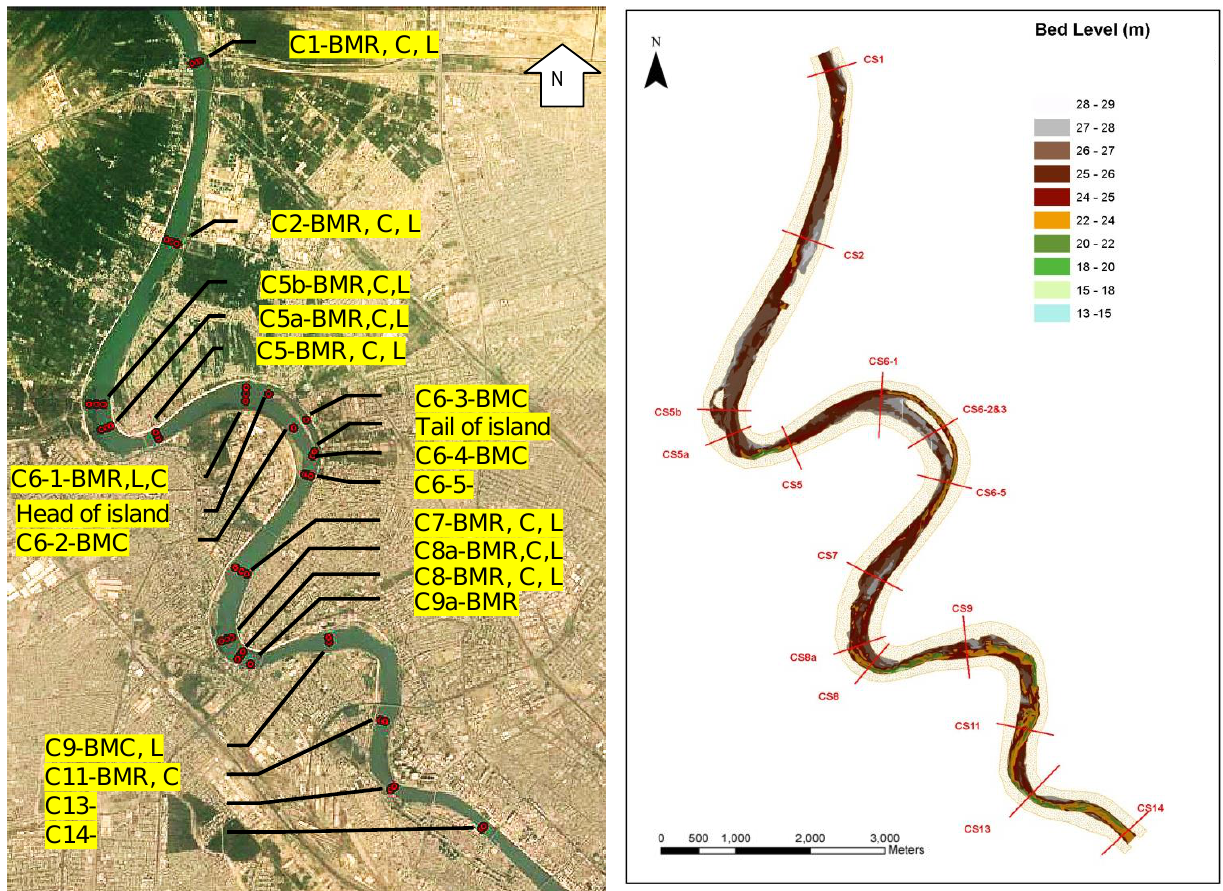
Figure 8. Bed level of Tigris River at Baghdad (above mean sea level). Figure 7. Location of the studied cross sections and sampling points. Figure 8: Bed level of Tigris River at Baghdad (above mean sea Figure 7: Location of the studied cross sections and sampling points.